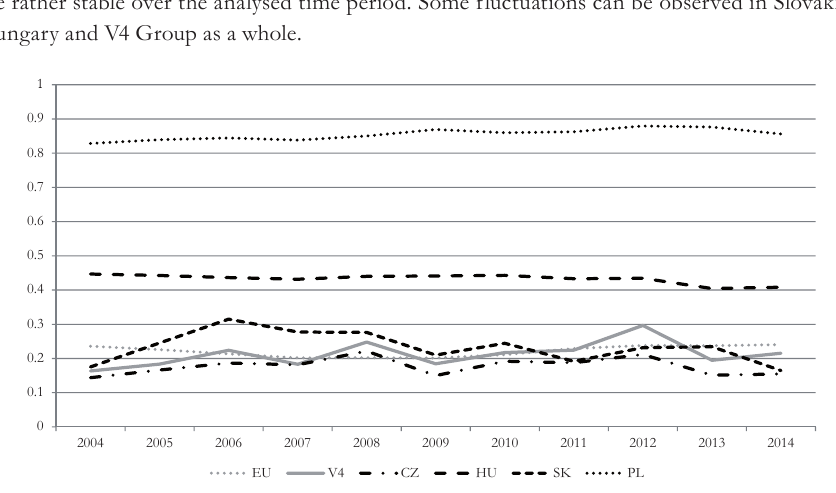
Fig. 2 – Weighted coefficient of variation values over the period of 2004-2014. Source: Author’s own investigation. It also seems interesting to investigate how the distance between the capital region and other regions developed over the analysed period. To carry out this analysis, the Euclidean distance was calculated between each region and the capital one. The average Euclidean distance be- tween Praha and other Czech regions increased from 0.94 in 2004 to 1.5 in 2014. The inequali- ties increase was also observed between Mazowieckie and other Polish regions – the distance increased from 0.28 in 2004 to 1.30 in 2014. Similarly, the Euclidean distance between Kozep- Magyarorszag and other Hungarian regions increased from 0.92 in 2004 to 1.16 in 2014. Signifi- cant fluctuations can be observed in Slovakia. The Euclidean distance between Bratislava region and other Slovak regions varying from 1.47 in 2004 to 5.56 in 2008, and finally, to 2.62 in 2014. The results are presented in Figure